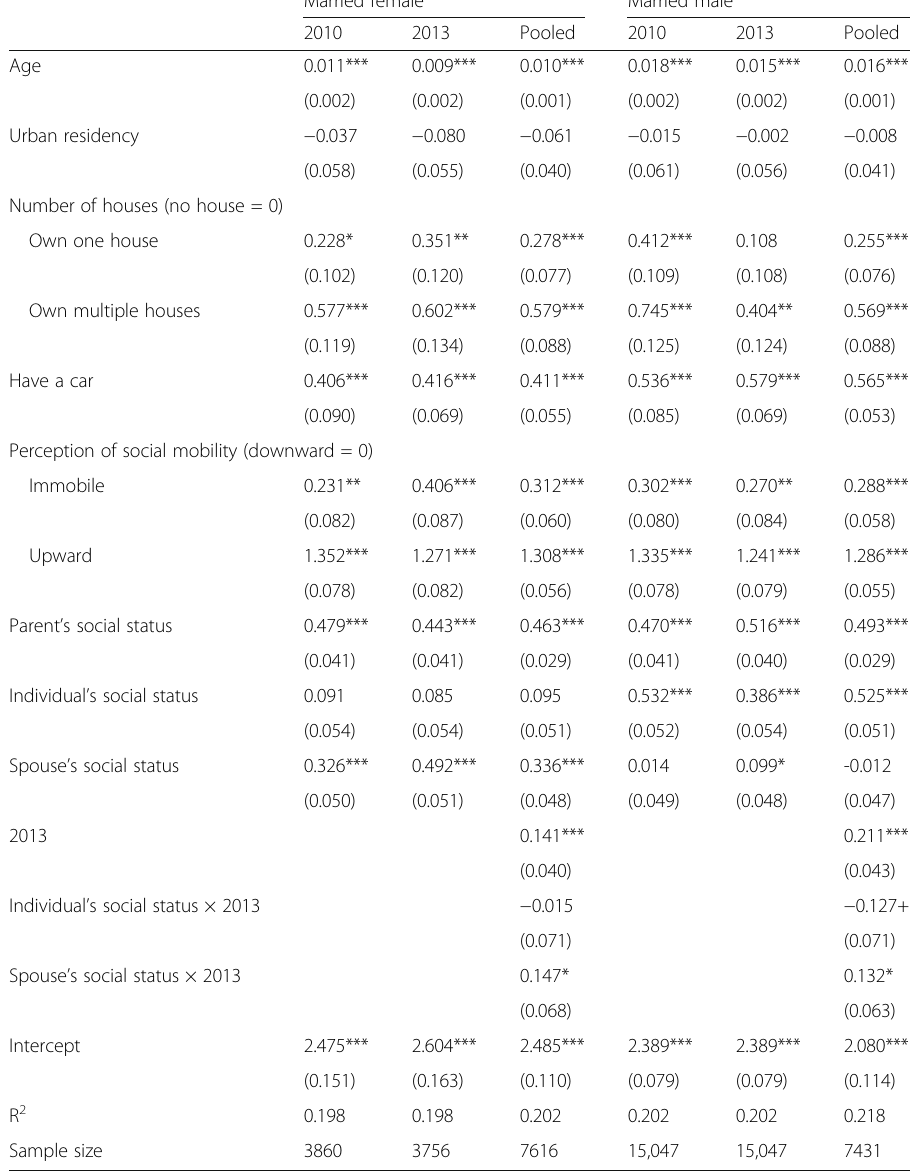
Table 7 Change in the effect of individual and spouse ’ s social statuses on class identity over time Married